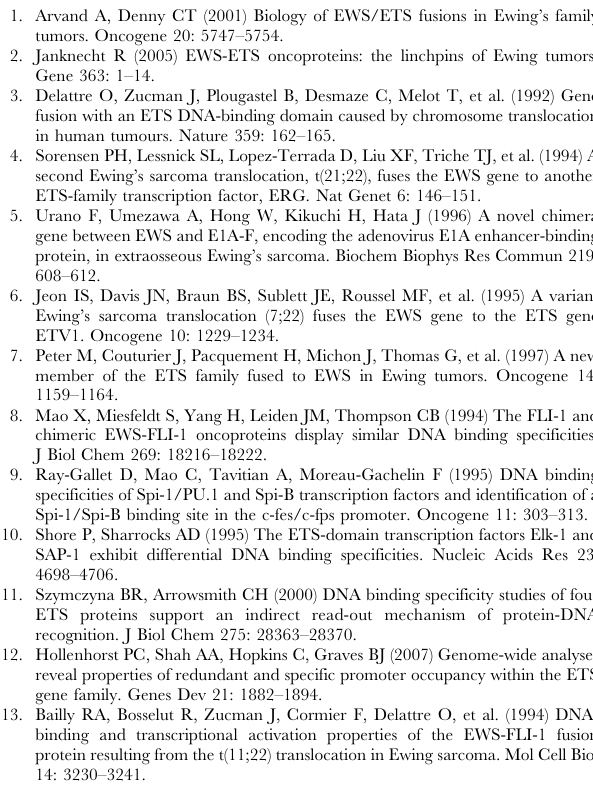
Table S1 246 EWS-FLI1-bound regions description